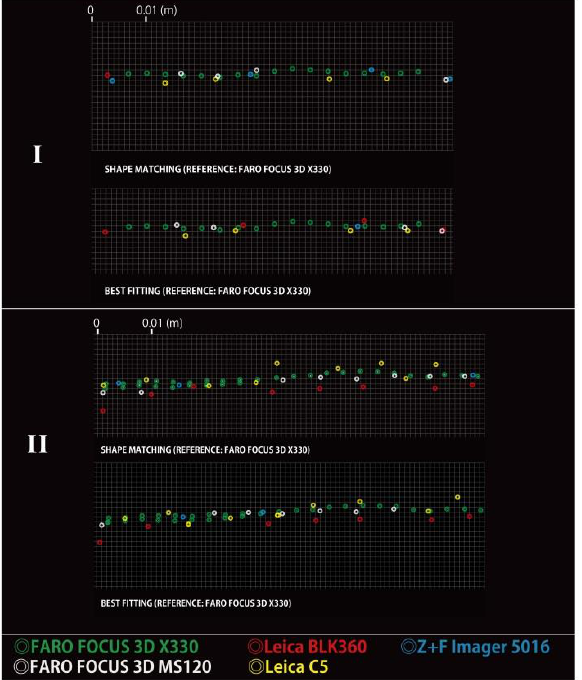
Figure 11: Alignments of Point Clouds (Refference:Leica Scan Station C5) 5.4 Leica BLK360 as the Reference